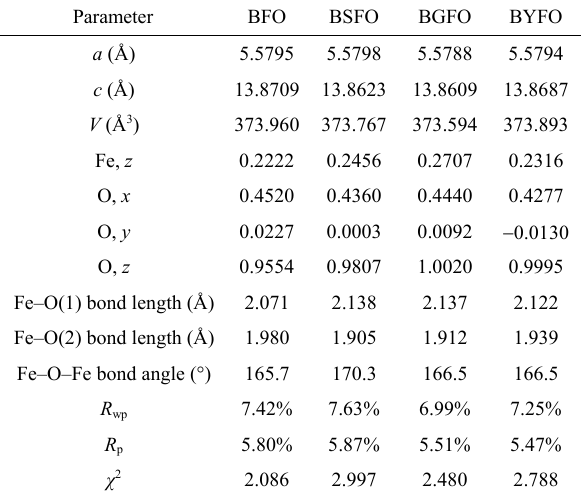
Table 1 Refined lattice parameters and structure fitting factors